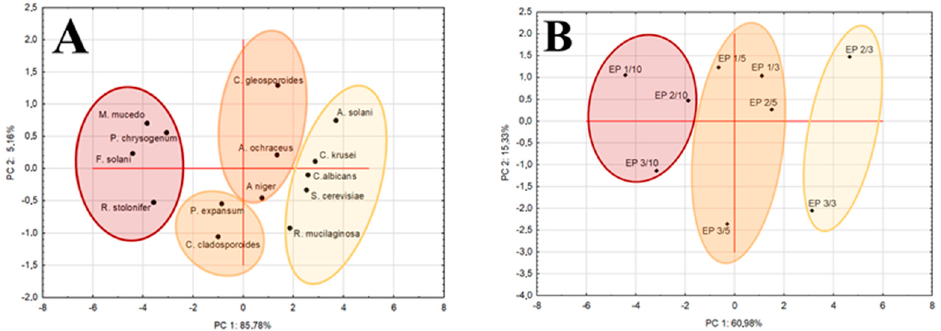
Figure 6. PCA map ( A , B ) from PLS-DA analysis based on the diameters of the zones of growth inhibition of the test strains and type of pullulan films with propolis extract.